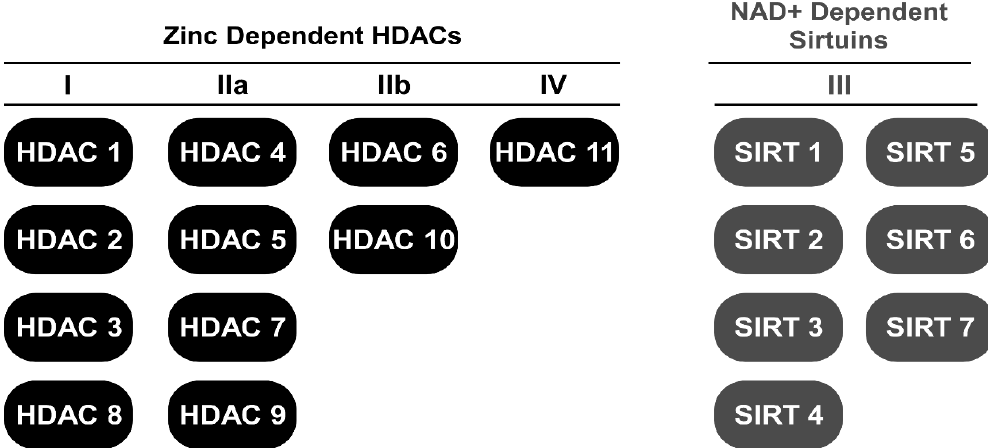
Figure 1. Schematic for HDAC classes dividing zinc-dependent HDACs from NAD + -dependent